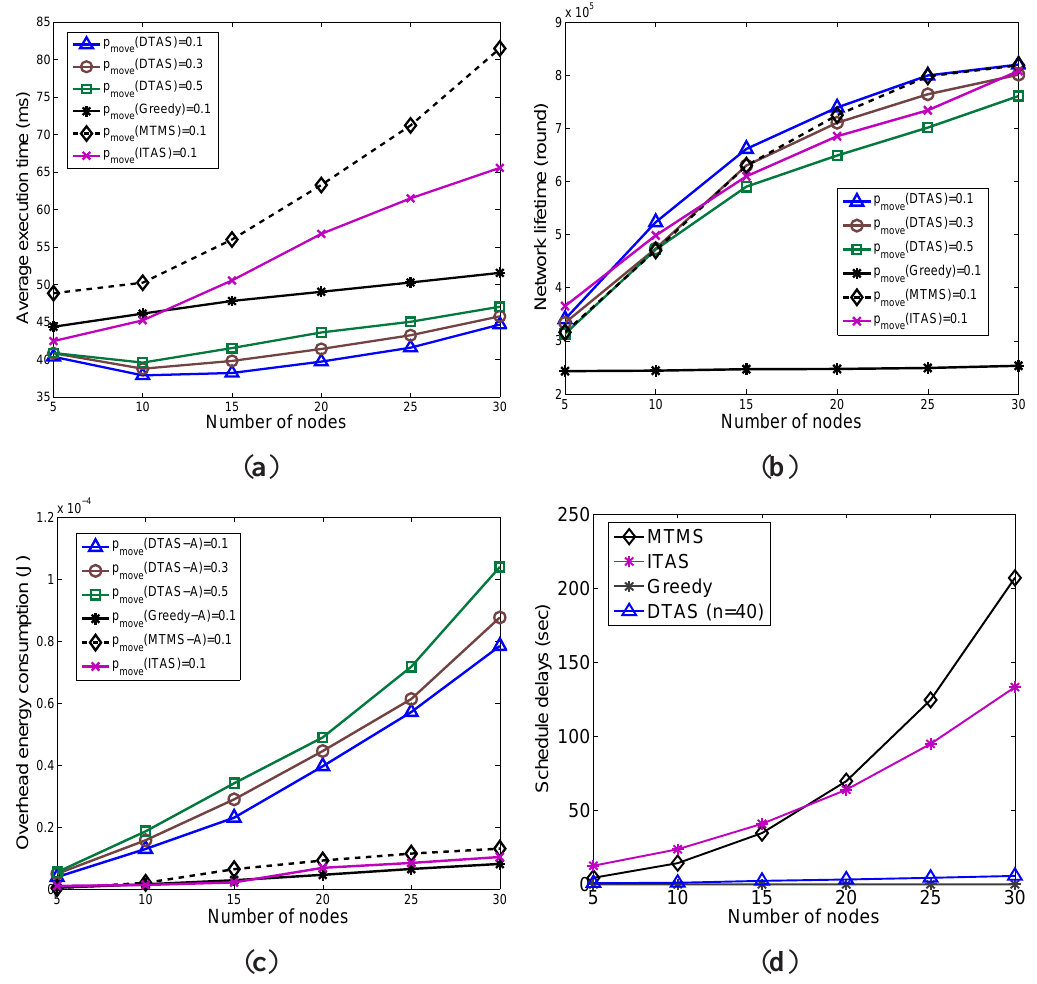
Figure 12. The effect of the number of nodes. ( a ) Average SL; ( b ) Average NL; ( c ) Energy consumption on overhead; ( d ) Scheduling